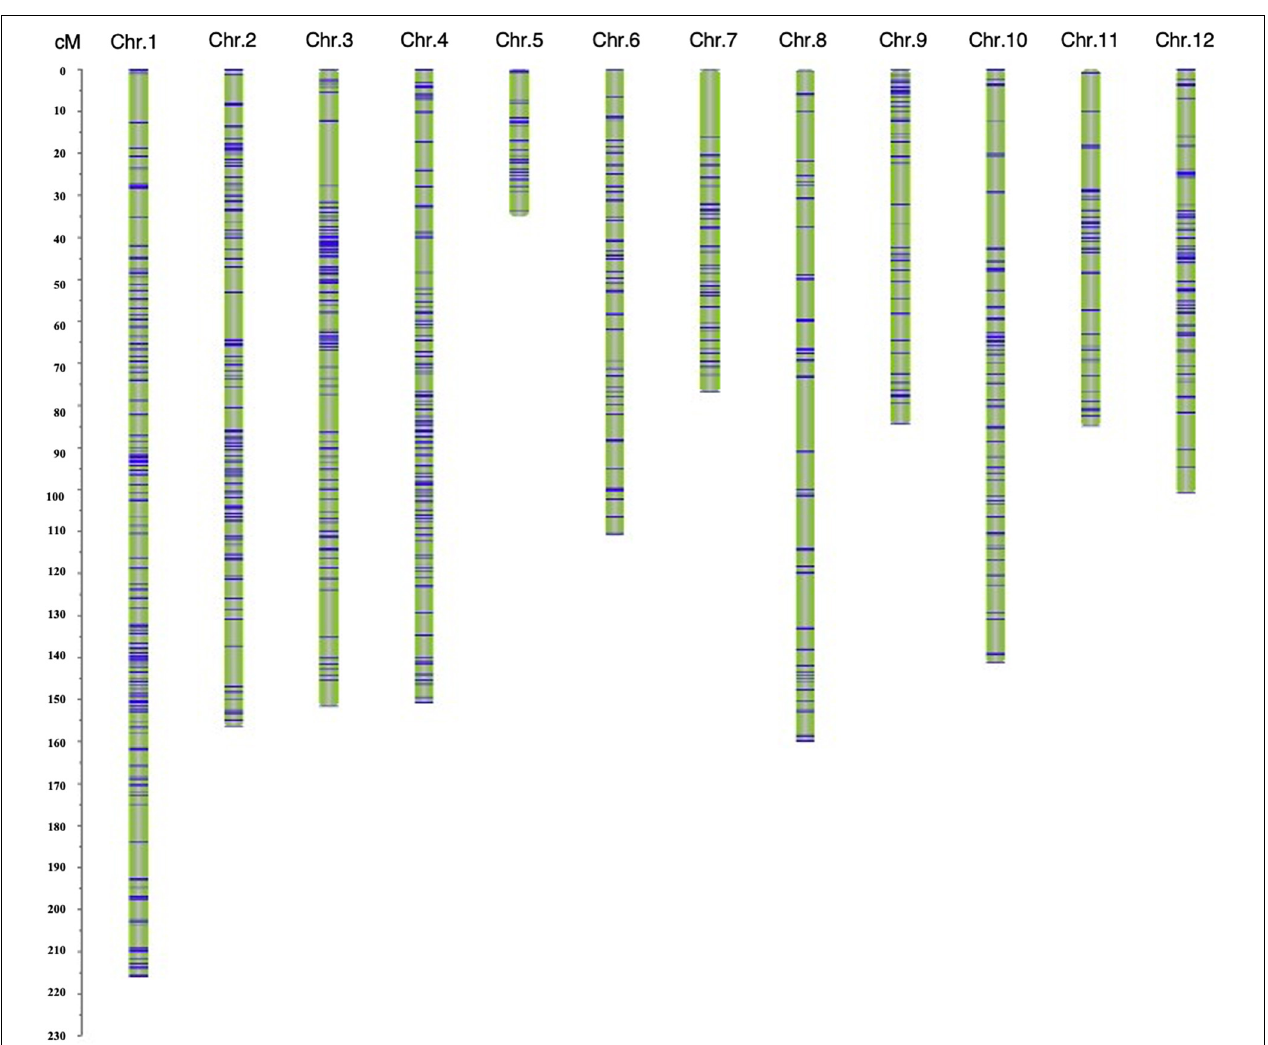
FIGURE 3 | The genetic linkage map of the F 2